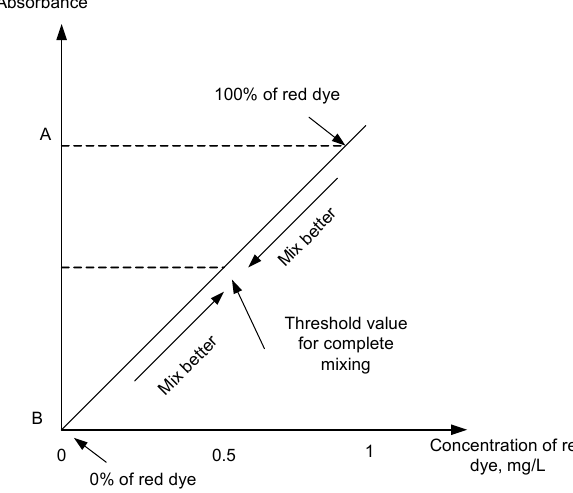
Figure 6. Concept of quantification of mixing performance.